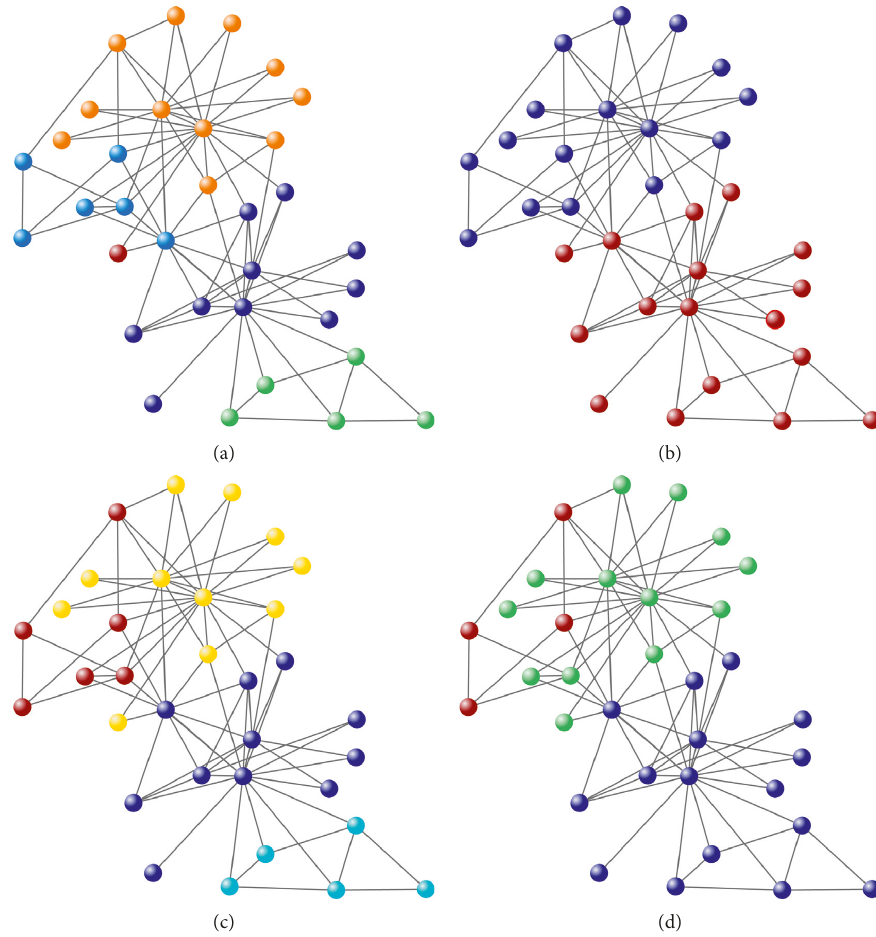
Figure 6: Different community detection methods applied to Zachary’s karate club network [44]: fast greedy partitioning (a); Kernighan–Lin bipartitioning (b); average-link hierarchical partitioning (c); complete-link hierarchical partitioning (d). Table 2: Computational time complexity and bibliographic references for the community detection techniques provided by NOESIS.